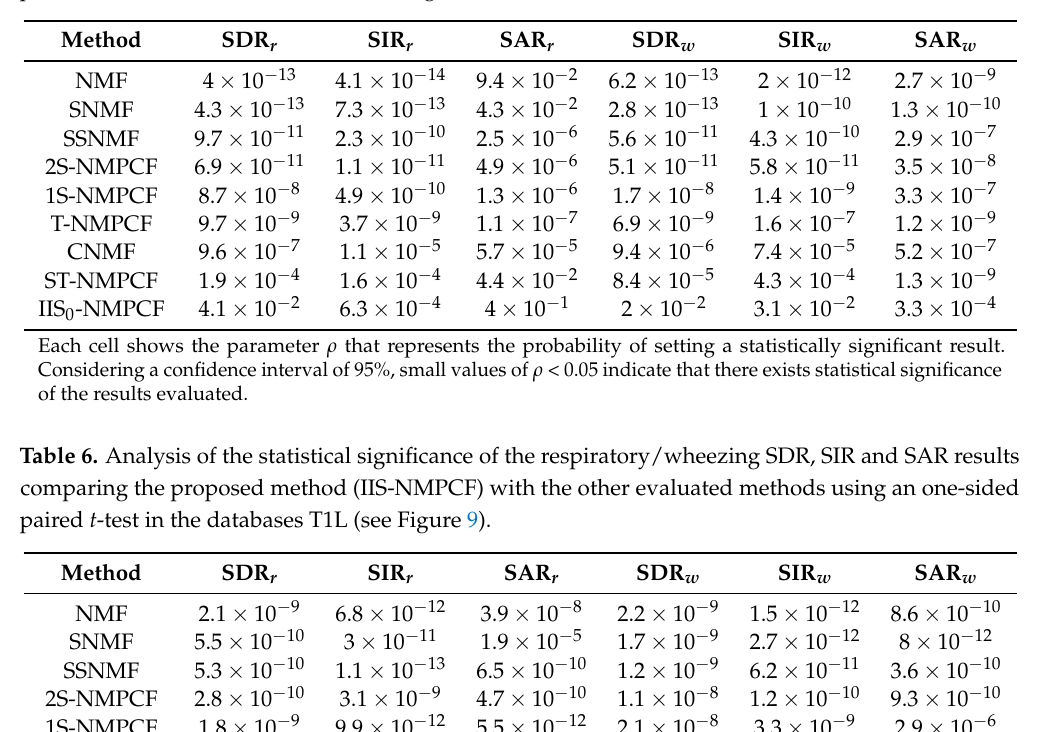
Table 5. Analysis of the statistical significance of the respiratory/wheezing SDR, SIR and SAR results comparing the proposed method (IIS-NMPCF) with the other evaluated methods using an one-sided paired t -test in the databases T1M (see Figure 8).